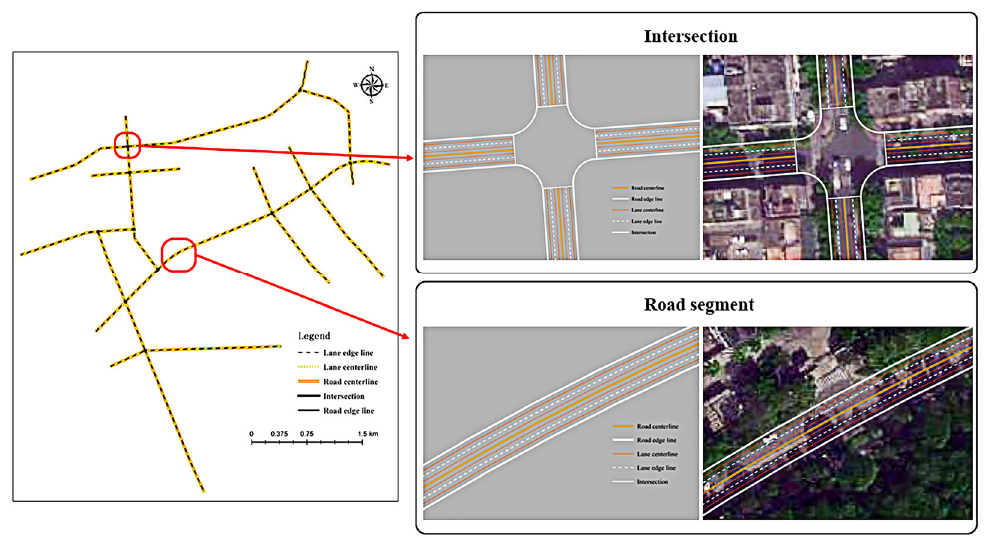
Figure 8. Road division and road centerline extraction.